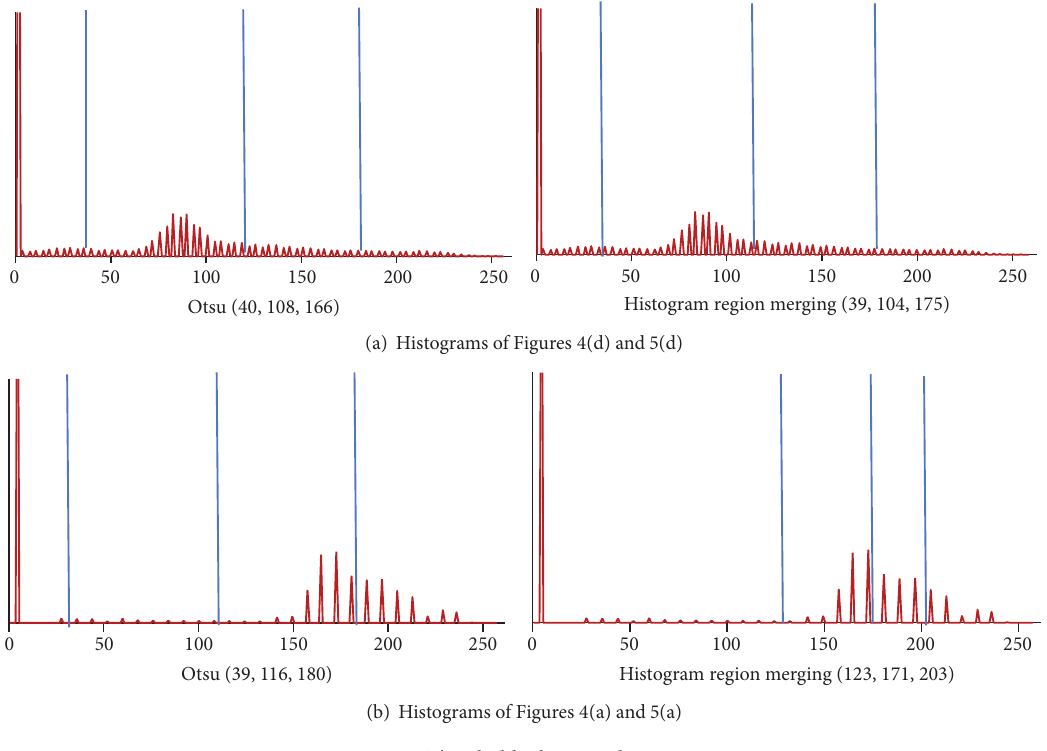
Figure 6: Thresholds shown in